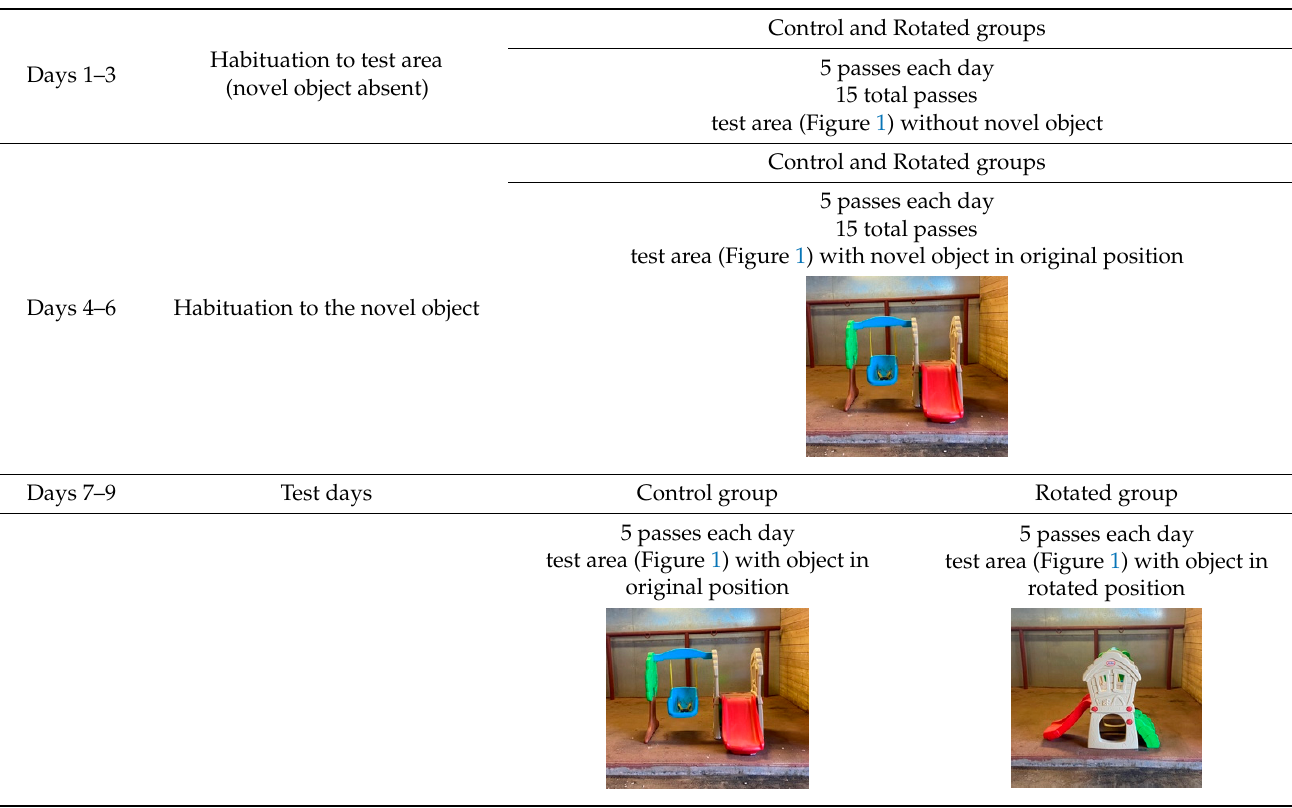
Table 1. Testing Procedure: Outline of testing procedure to provide details of the Control and Rotated group procedures.